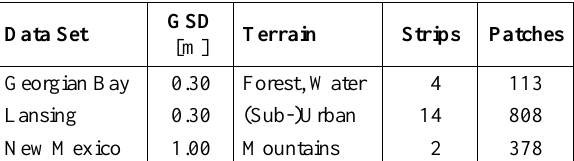
Table 1. ADS data sets used for verification of the point cloud matching.